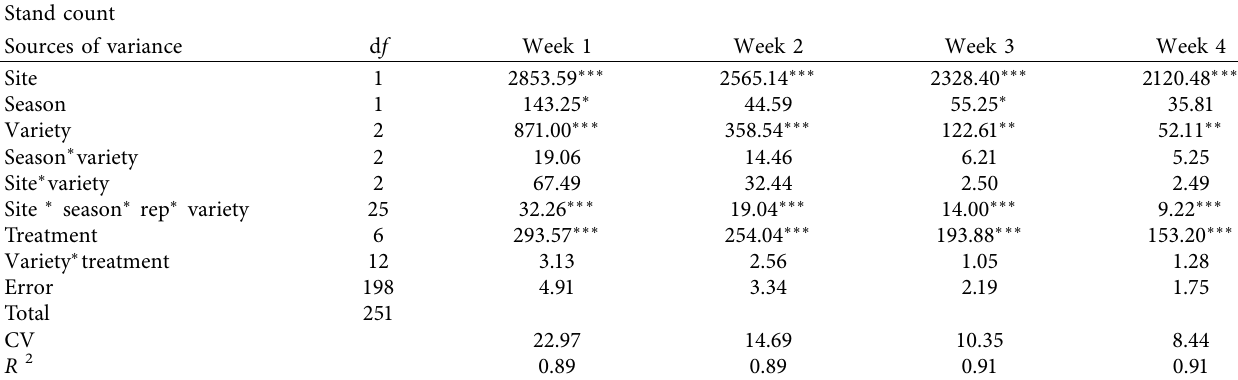
Table 5: The mean squares for three potato varieties on germination (stand count) at different weeks after planting. Stand count